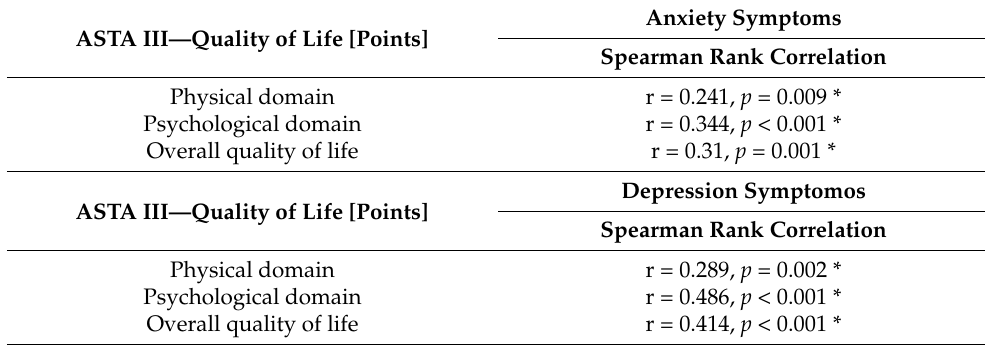
Table 5. Correlation between quality of life (ASTA III) and anxiety and depression symptoms (HADS-M). Anxiety Symptoms ASTA III—Quality of Life [Points] Spearman Rank Correlation Physical domain r = 0.241, p = 0.009 * Psychological domain r = 0.344, p < 0.001 * Overall quality of life r = 0.31, p = 0.001 * Depression Symptomos ASTA III—Quality of Life [Points] Spearman Rank Correlation Physical domain r = 0.289, p = 0.002 * Psychological domain r = 0.486, p < 0.001 * Overall quality of life